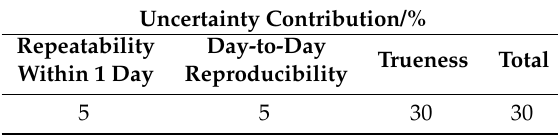
Table A7. Relative uncertainty budget for ultraviolet–visible (UV-vis) spectroscopy.